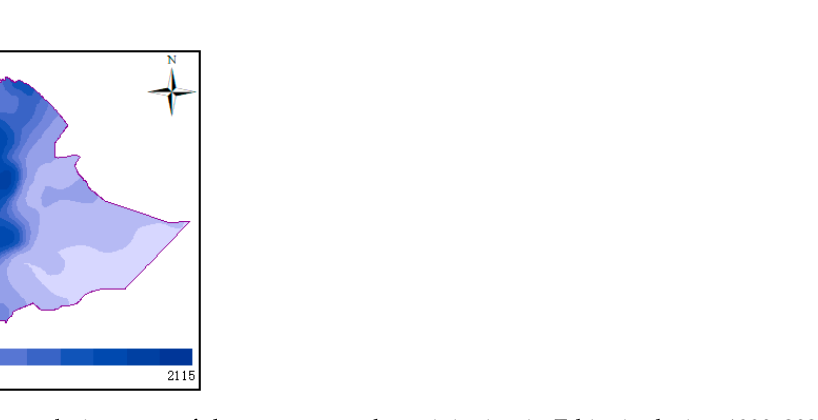
Figure 5. High-resolution maps of the mean monthly precipitation in Ethiopia during 1990–2020 generated using the hybrid of MLPs.